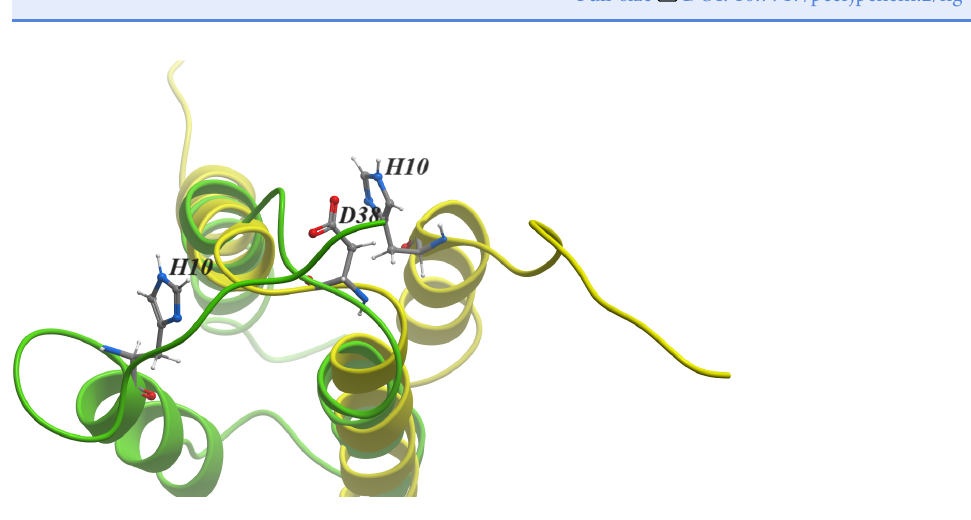
Figure 2 Green- and yellow-ribbon diagrams for the native and ‘‘mirror’’ image conformations of Protein A, respectively. The position of the side-chain of H10 is highlighted for each of these conforma- tions. Moreover, the side-chain of D38 is also displayed to point out the close proximity between D38 and H10 in the mirror image conformation. The favorable electrostatic interaction between D38 and H10 may be responsible for the large ( (cid:49) ≈ − 1 . 1) change in the computed pKa between the native-like and the mirror-image